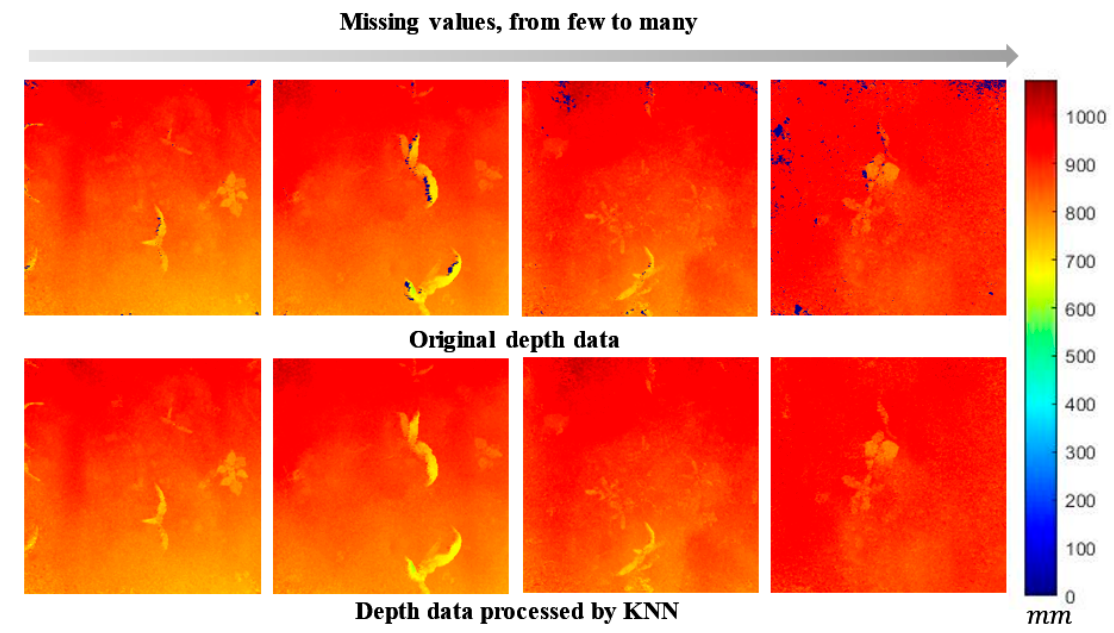
Figure 3. The result of using KNN to repair images with deep missing values. The first line of the image shows the gradual increase of the missing depth value from left to right. The bottom of each picture in the first row corresponds to the result after using KNN to repair.